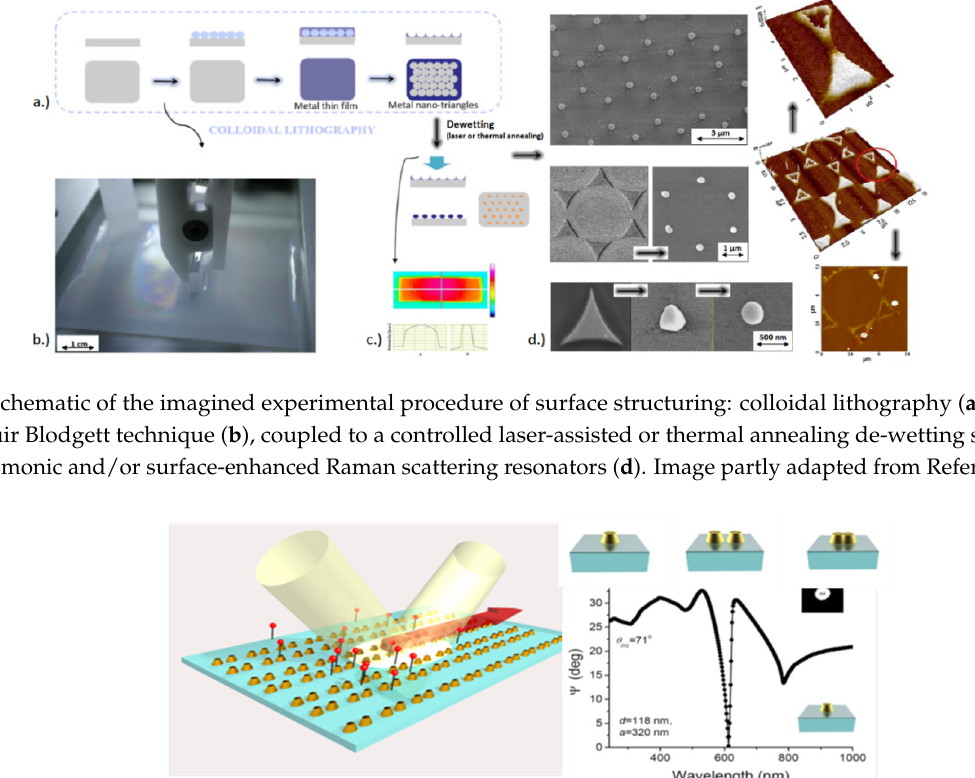
Figure 14. Schematic of a single molecule detection via surface lattice resonances. General presentation of measurements (left) and the surface lattice resonances in Au arrays (right). Such periodical resonating structures could be produced by means of cost-efficient LIFT and/or colloidal lithography followed by laser or thermally induced de-wetting effects, instead of the expensive e-beam lithography. Adapted from Reference [174].